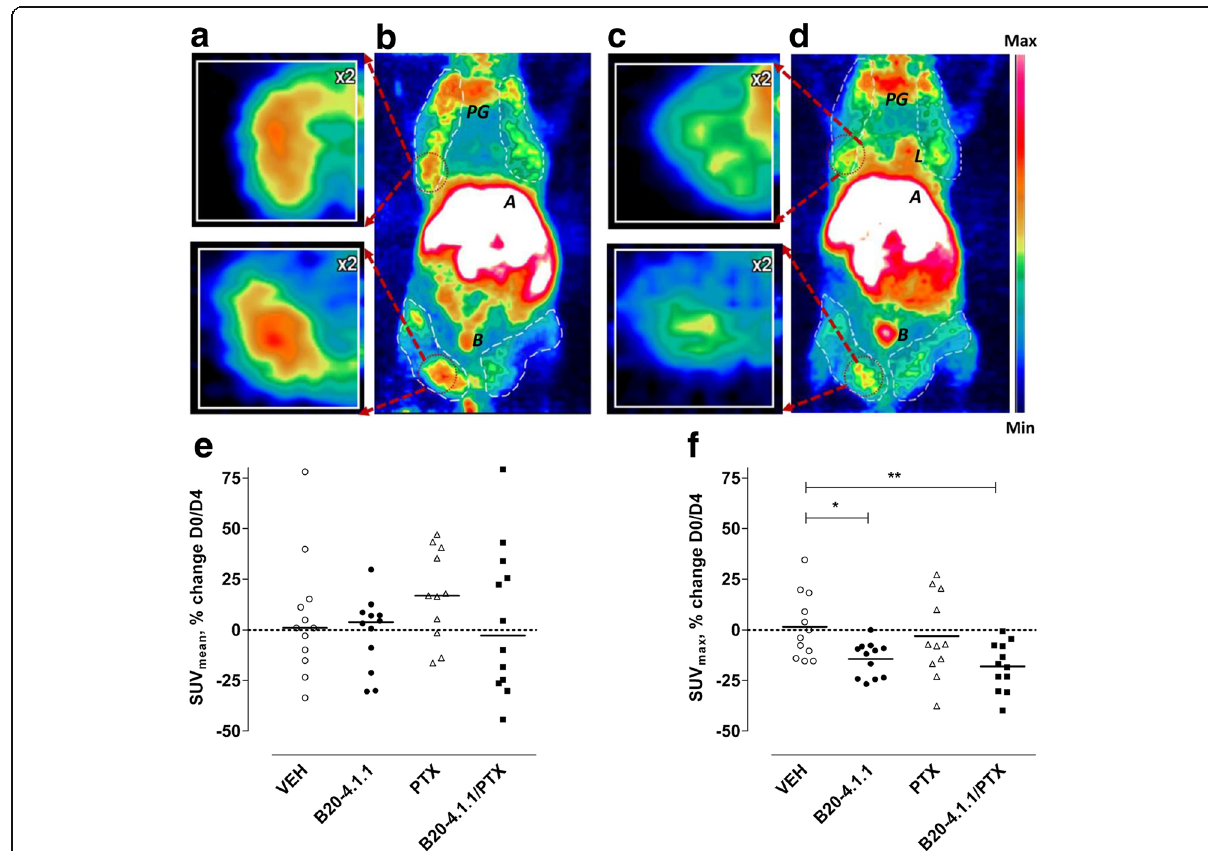
Fig. 1 Therapy response assessments in PyMT mice with ( R )-[ 11 C]aPAQ PET imaging. The ( R )-[ 11 C]PAQ uptake in PyMT mouse a , b before (baseline, day 0) and c , d 4 days after B20-4.1.1/PTX combinational treatment (shown as example). The twofold magnified boxed areas ( a , c upper and lower images) show transverse plane through the corresponding mammary tumors area (red dotted circles). The white dashed areas on b and d represent the mammary tumor areas, included in PET/MRI analyses. PG, parotid glands; A, abdomen; B, bladder. All images are scaled to the same color scale. Quantification summary of ( R )- [ 11 C]PAQ uptake e SUV mean and f SUV max values as a percentage of change from baseline, day 0 to day 4 in all treatment groups ( n =11 – 12 tumors/group). The comparisons between the groups are shown (Kruskal-Wallis test, * p <0.05 and ** p <0.01). Each individual tumor is presented as a dot. The horizontal lines indicate the median